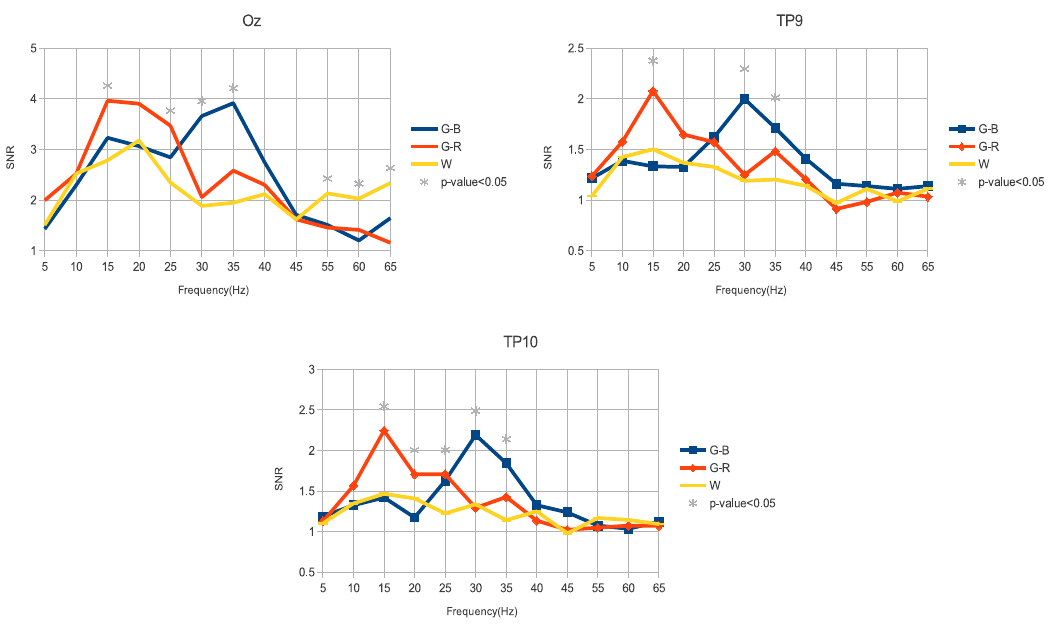
Figure 5. Average of the SSVEP SNR of all volunteers for the Oz, TP9, and TP10 channels using the three different stimulus configurations. The frequencies with statistical significance ( p -value < 0.05) based on the Friedman test are marked with an